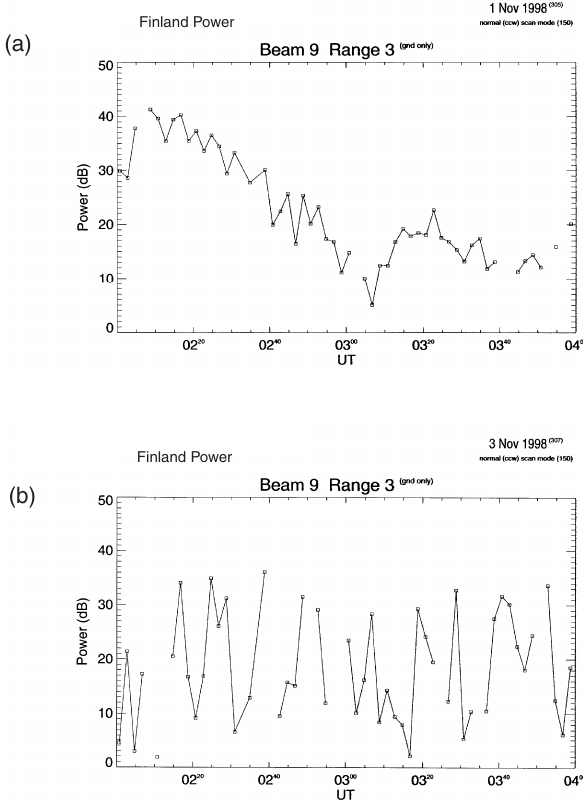
Fig. 4. Variations in SuperDARN Finland power returns from beam 9, range gate 3 flagged as “ground scatter” between 02:00–04:00UT (a) 1 November 1998 (b) 3 November